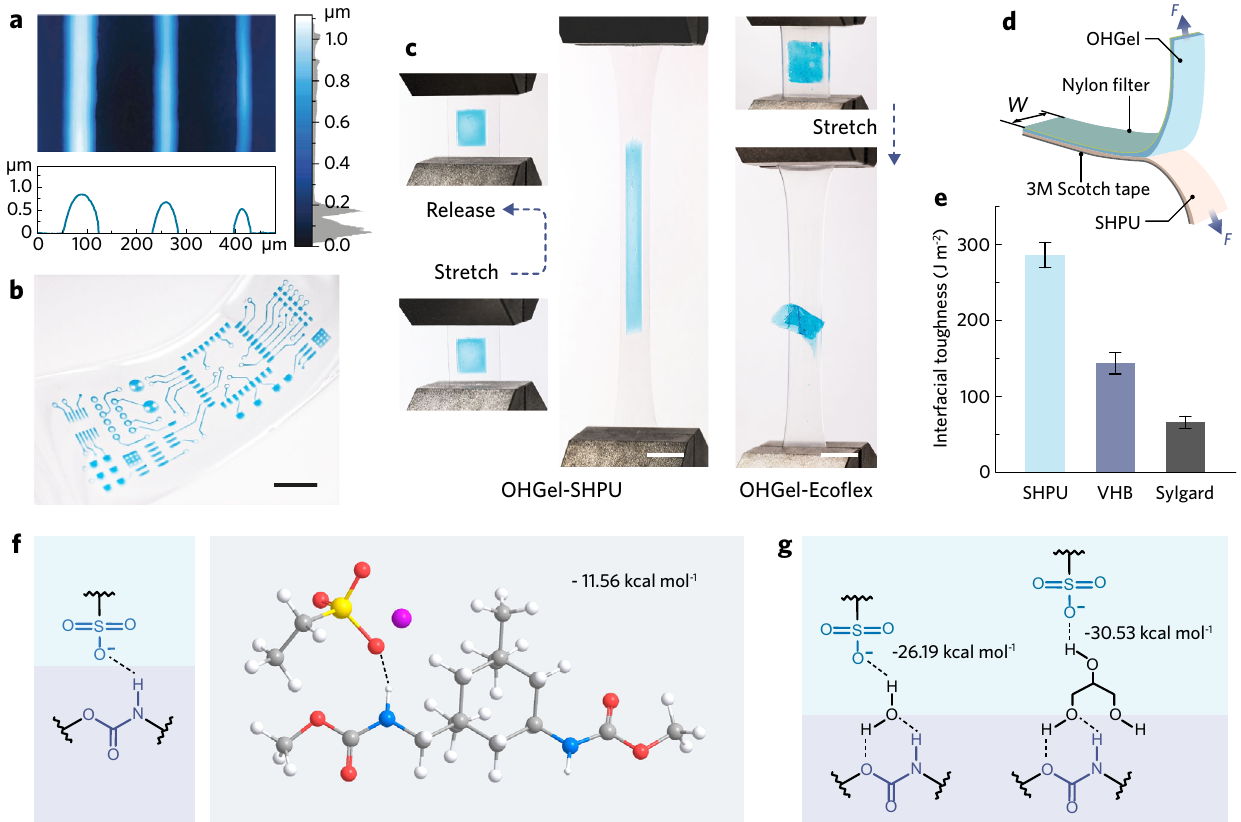
Fig. 3 | Additive manufacturing and robust OHGel-SHPU interface. a 3D- topography of inkjet-printed OHGel lines captured by confocal microscope. b Photograph of an inkjet-printed OHGel-SHPU ionic circuit with sophisticated electrode patterns. Scale bar, 5mm. c Photographs showing an OHGel-SHPU composite under large tensile deformation ( ε >600%) without debonding, and an OHGel-Eco fl ex composite delaminating under much lower strain ( ε <100%). Scale